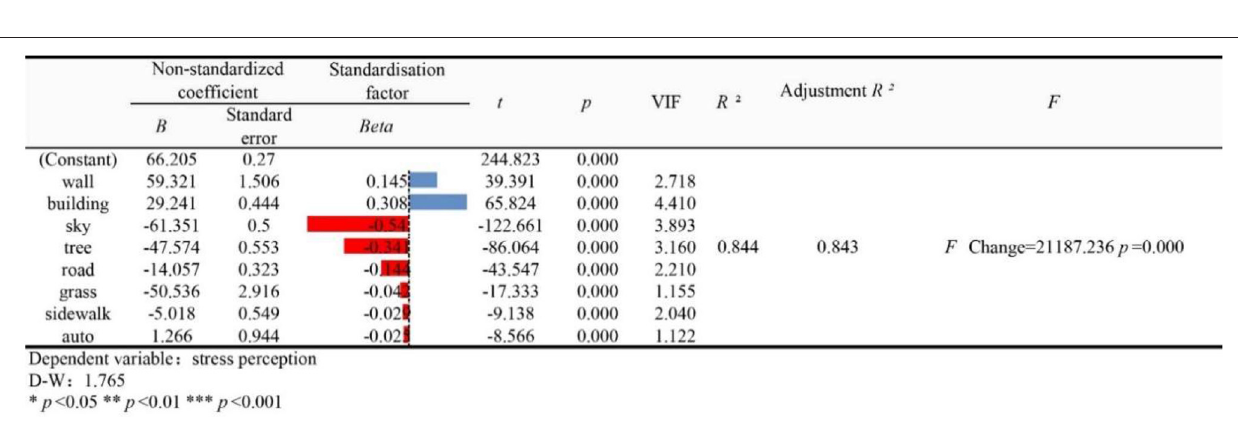
FIGURE 14 | Results of linear regression analysis for perceived